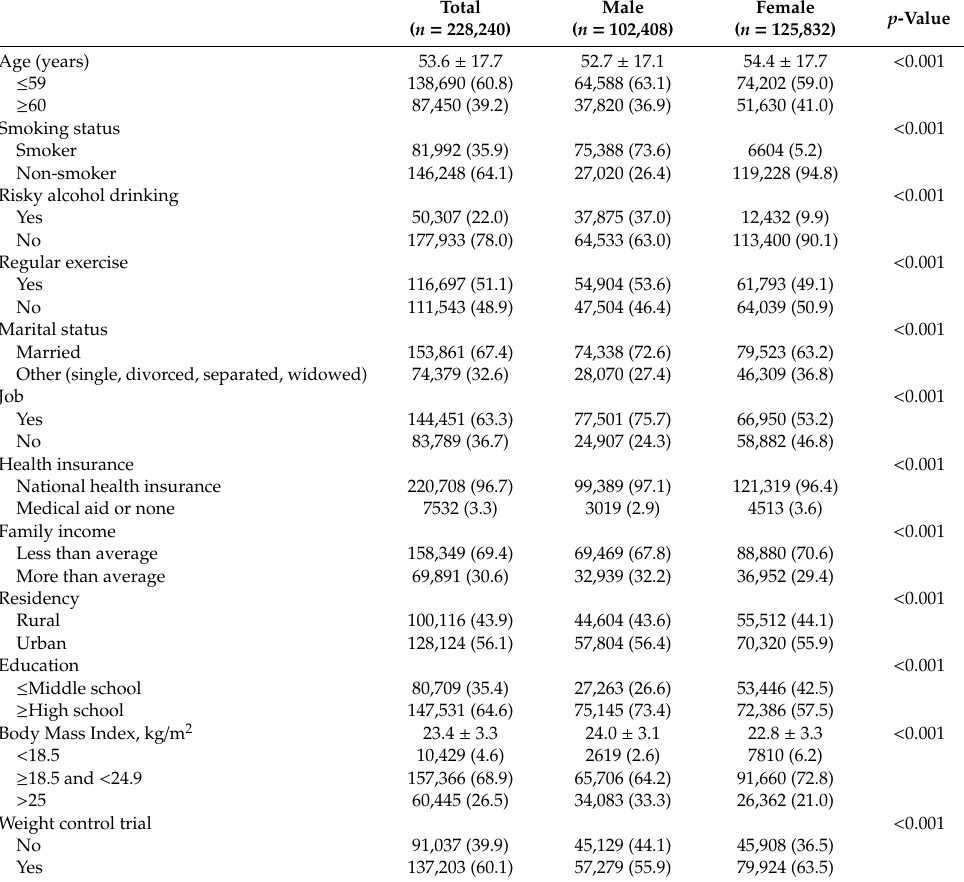
Table 1. Sociodemographic and clinical characteristics of the study